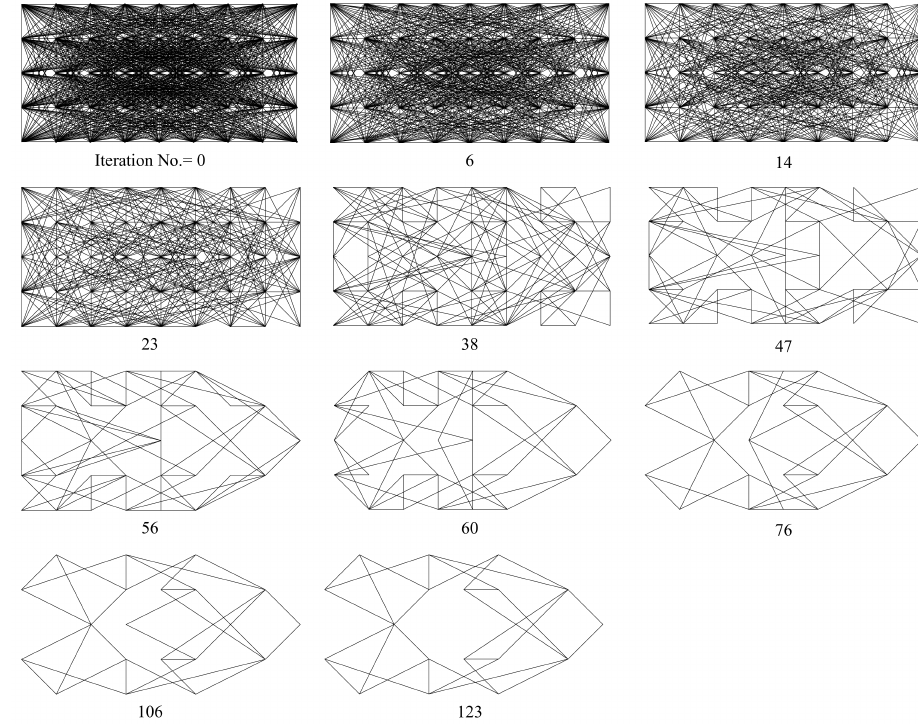
Figure 16. Topology evolution of the 662-bar truss.